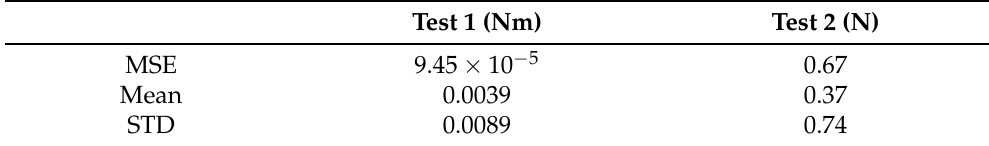
Figure 11. Histogram of mean square error. Table 3. Statistical value of prove